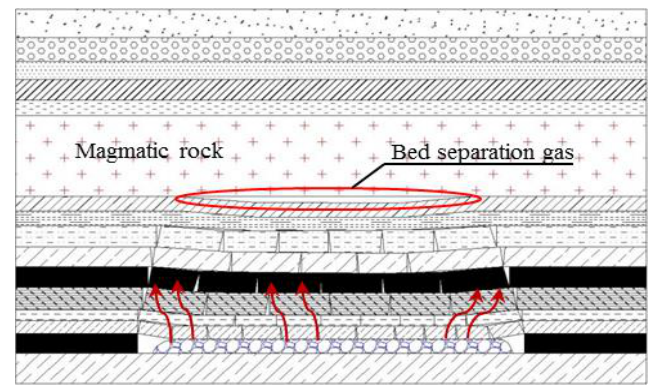
Figure 9. Schematic diagram of the formation of bed separation gas.